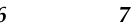
Table 6. Short-run coefficient estimates of U.S. economic policy uncertainty on U.S. imports from Korea.